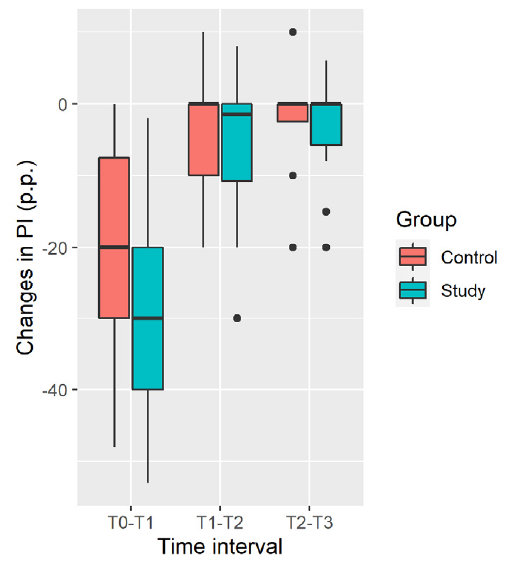
Figure 2. Distribution of changes in plaque index (percentage points).